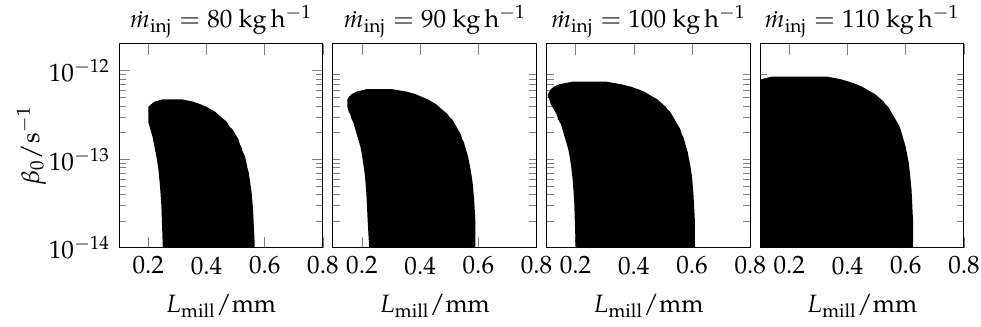
Figure 8. Stable (white) and unstable (black) regions for variations of the binder injection rate. The feed of external nuclei creates new nuclei for agglomeration and layering. The main reason for the occurrence of self-sustained oscillations is that only few new nuclei are added in the “growing phase” and the NDF maintains its narrow shape. Therefore, reducing the number of new nuclei by decreasing the feed rate ˙ m feed promotes the occurrence of limits cycles and the expansion of the unstable region as presented in Figure